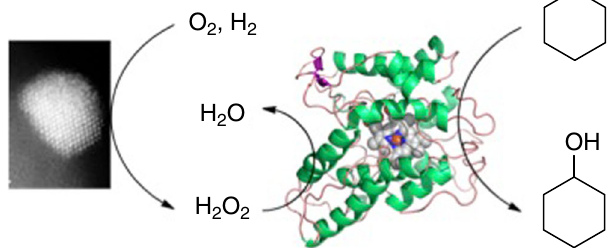
Fig. 1 Proposed reaction system. A combination of heterogeneous catalysis and biocatalysis can be used to oxidize cyclohexane using in situ produced H 2 O